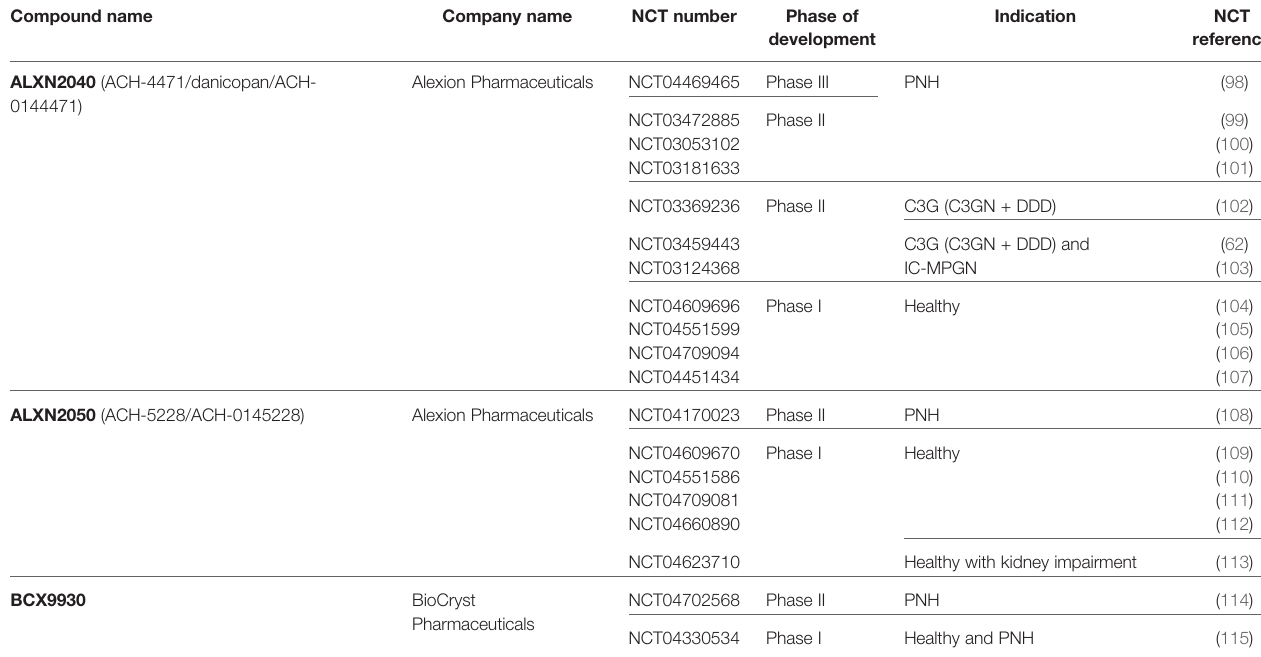
TABLE 1 | Small-molecule factor D inhibitors in clinical